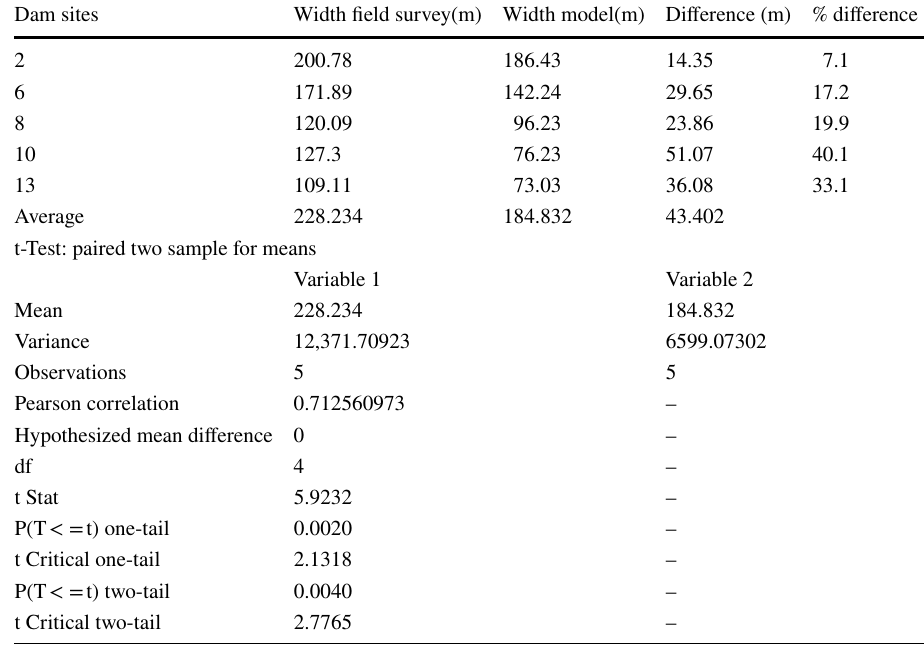
Table 6 t-Test between the field survey and semi-automatic